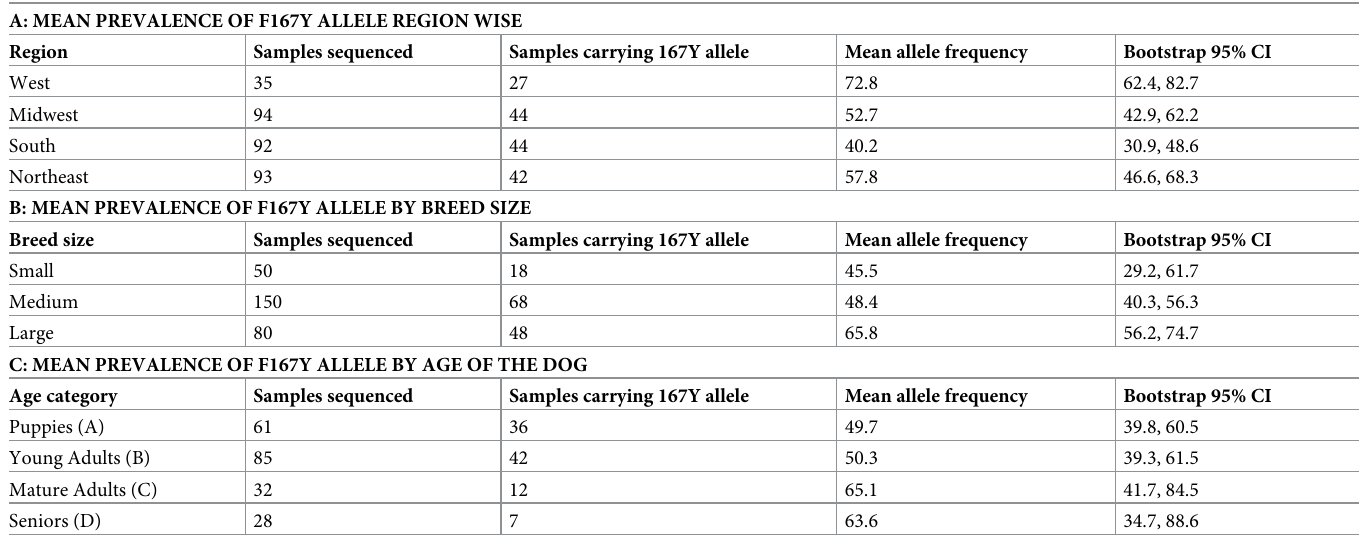
Table 1. Prevalence of the F167Y(TTC > TAC) mutation. A: MEAN PREVALENCE OF F167Y ALLELE REGION WISE